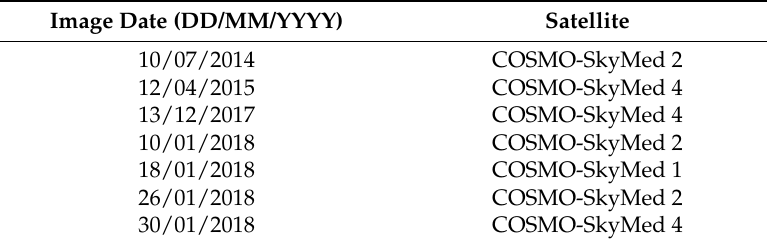
Table 1. COSMO-SkyMed StripMap HIMAGE scenes used for the analysis of the December 2014 and January 2018 events that occurred within the Nasca Lines WHS at the locations reported in Figures 1 and